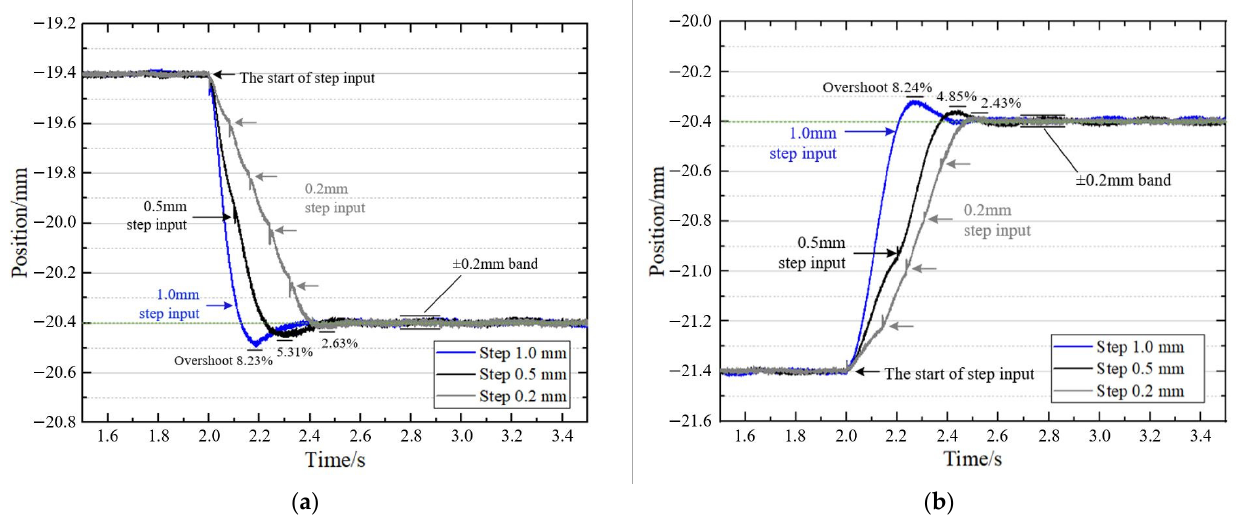
Figure 11. Dynamic real-time position response of three step inputs of controlled levitating object. ( a ) Descending motion; ( b ) Ascending motion.